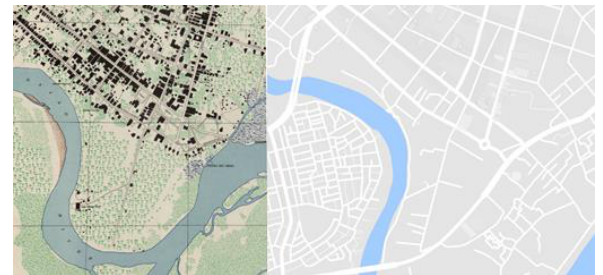
Figure 13. Left - 1944 map showing Davao River courtesy of the University of Texas Libraries. Right - corresponding Google Map.